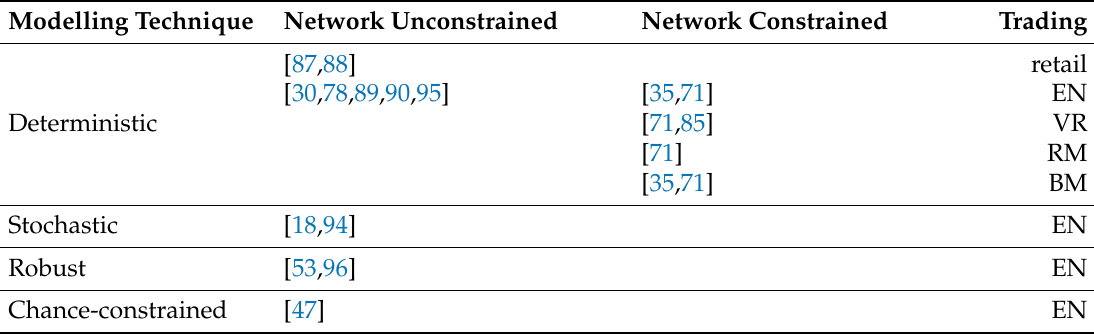
Table 2. Literature survey on the ESS operating at the distribution level. (Abbreviations: EN, energy only; VR, voltage regulation; RM, reserve market; BM, balancing